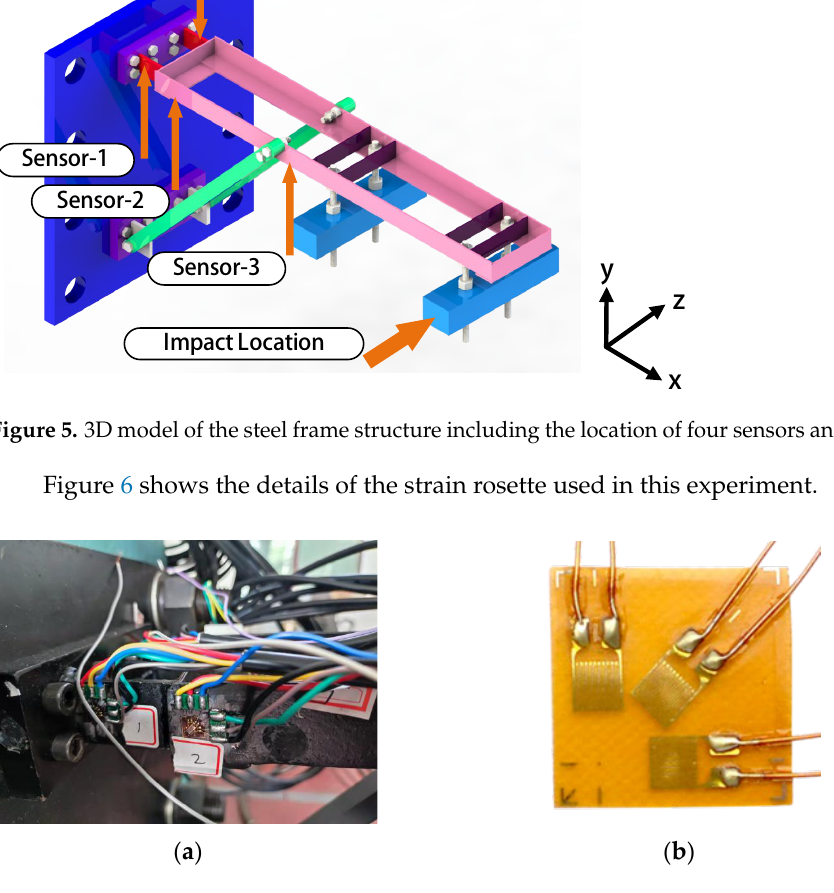
Figure 6. ( a ) The real configuration of one sensor (strain rosette). ( b ) The specific structure of one strain rosette. Table 1 listed the exact location of the force hammer and four sensors (strain rosette) in the space coordinate